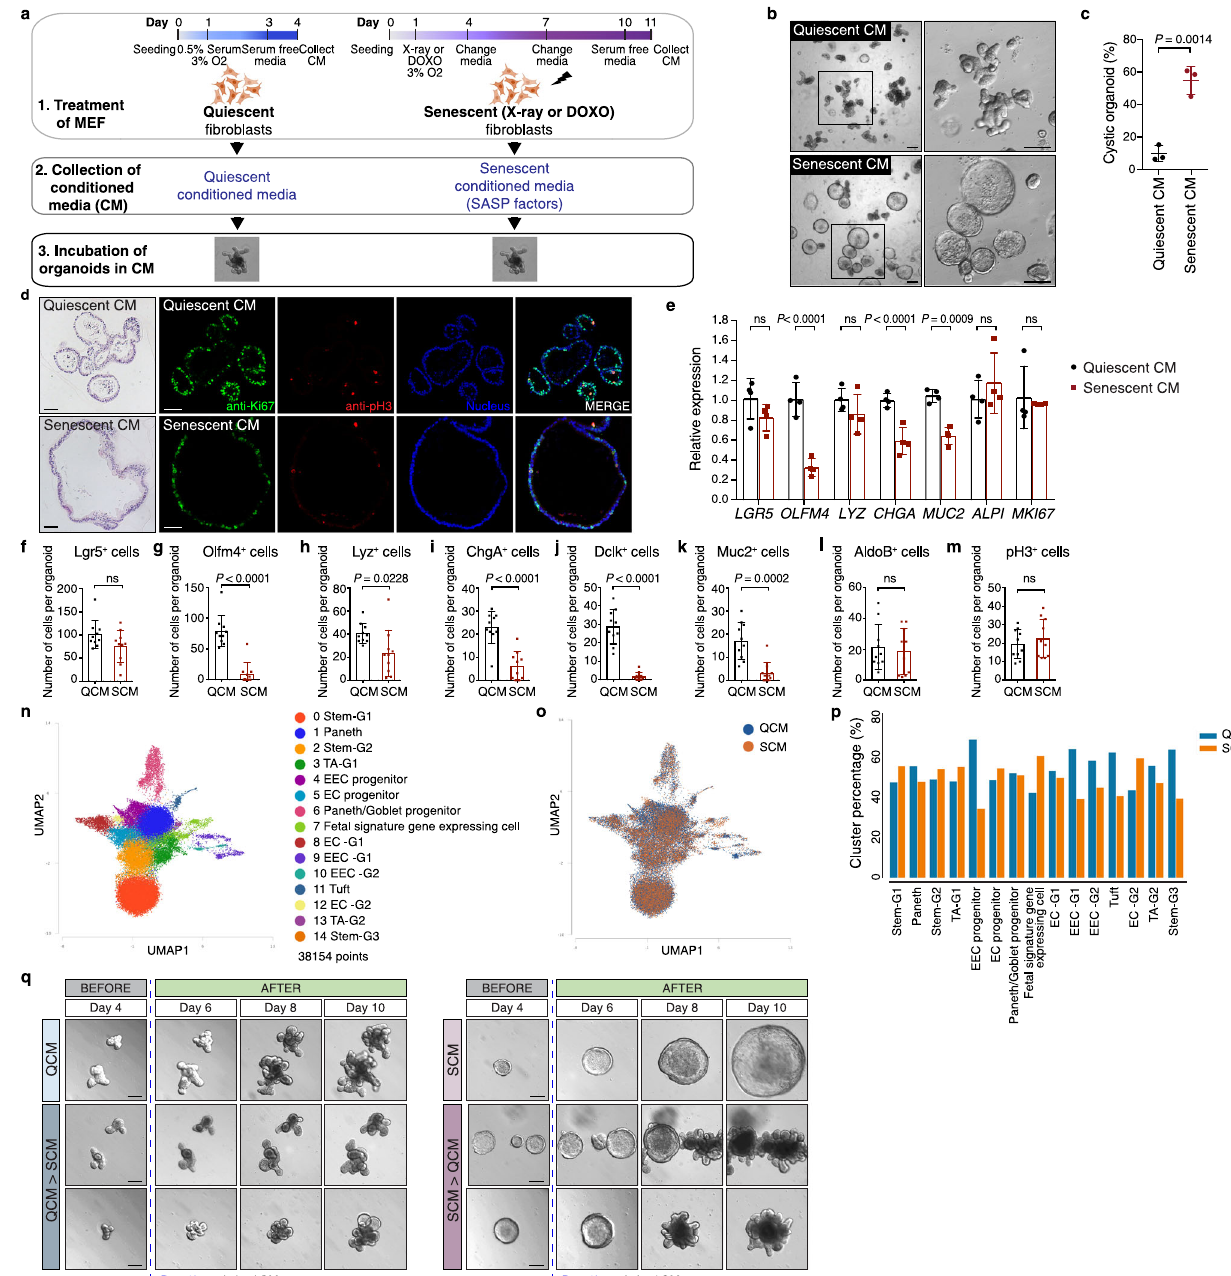
Fig. 1 | Conditioned medium from senescent fi broblasts causes cystic mor- phology of mouse intestinal organoids. a Schematic showing induction of quiescence and senescence in fi broblasts, conditioned media collection, and organoid culture in conditioned media. The fi gure was created with BioR- ender.com. b Representative images of organoids after 5 d of culture in condi- tioned media. Enlarged images (boxed area) are shown at the right. Scale bar, 200 μ m. c Quanti fi cation of data from ( b ). The percentage of cystic organoids in organoids cultured in conditioned media is shown (mean ± s.d.; two-tailed t -test). Eachdotrepresentsaresultfromorganoidsestablishedfromamouse,3biological replicatesperexperiment( n =3). d H&Estaining(leftcolumn)andimmunostaining of paraf fi n-embedded organoids. Immunostaining for Ki67 (green) and phospho- Histone H3(red)in intestinalorganoidscultured in conditioned mediaandstained with Hoechst (blue). Scale bar, 50 μ m. e Gene expression in organoids exposed to SCMdeterminedbyqPCRandrepresentedasaratiorelativetoorganoidsexposed to QCM (mean ± s.d.; n =4; two-tailed t -test). f – m Numbers of cells expressing the